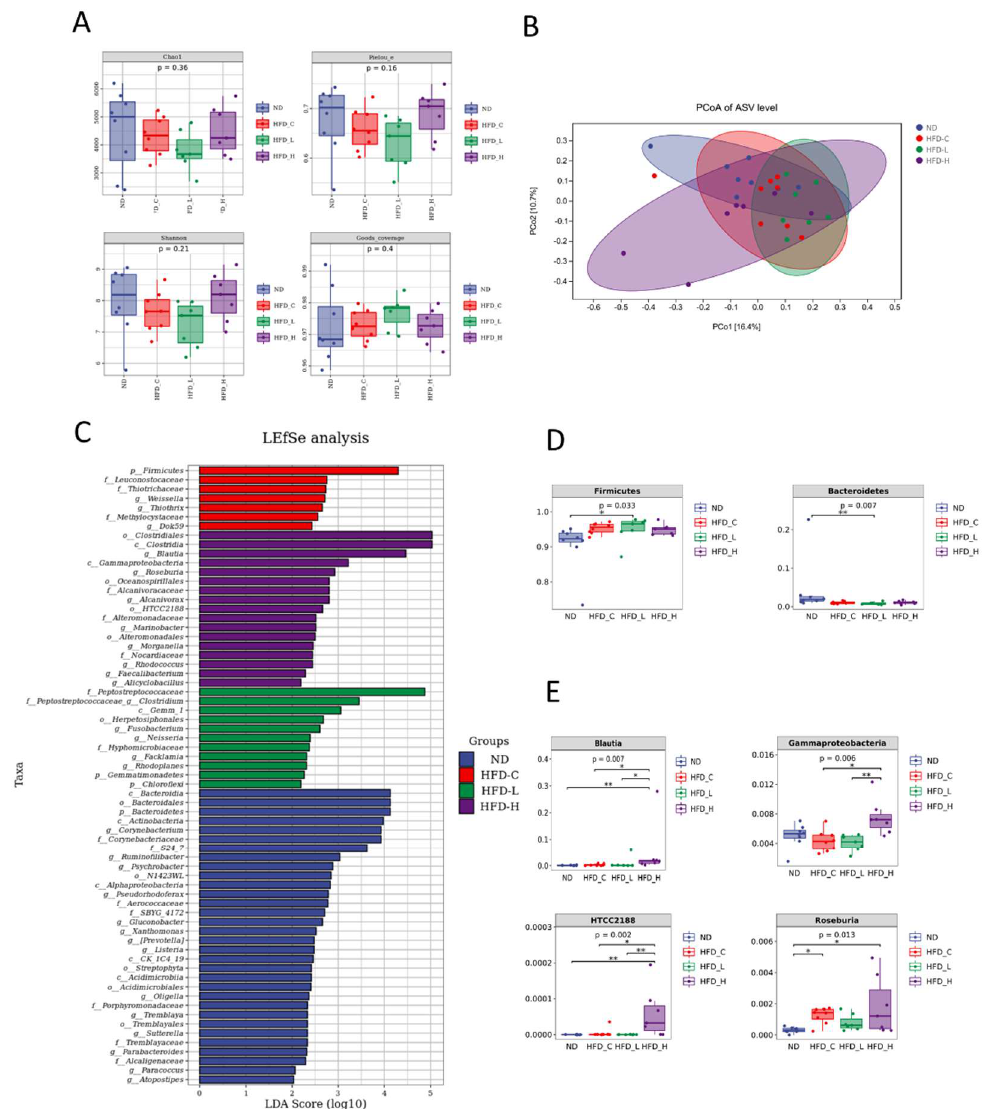
Figure 4. Supplementation of symbiotics altered the gut microbiota composition. ( A ) Alpha diversity, ( B ) beta diversity, ( C ) linear discriminant analysis effect size (LEfSe) histogram showing microbiota significantly enriched within each group. ( D ) The phylum-level proportional abundances of Firmicutes and Bacteroidetes. ( E ) The abundance of core microbiota significantly altered in HFD_H compared with HFD_C. * p < 0.05 and ** p < 0.01.